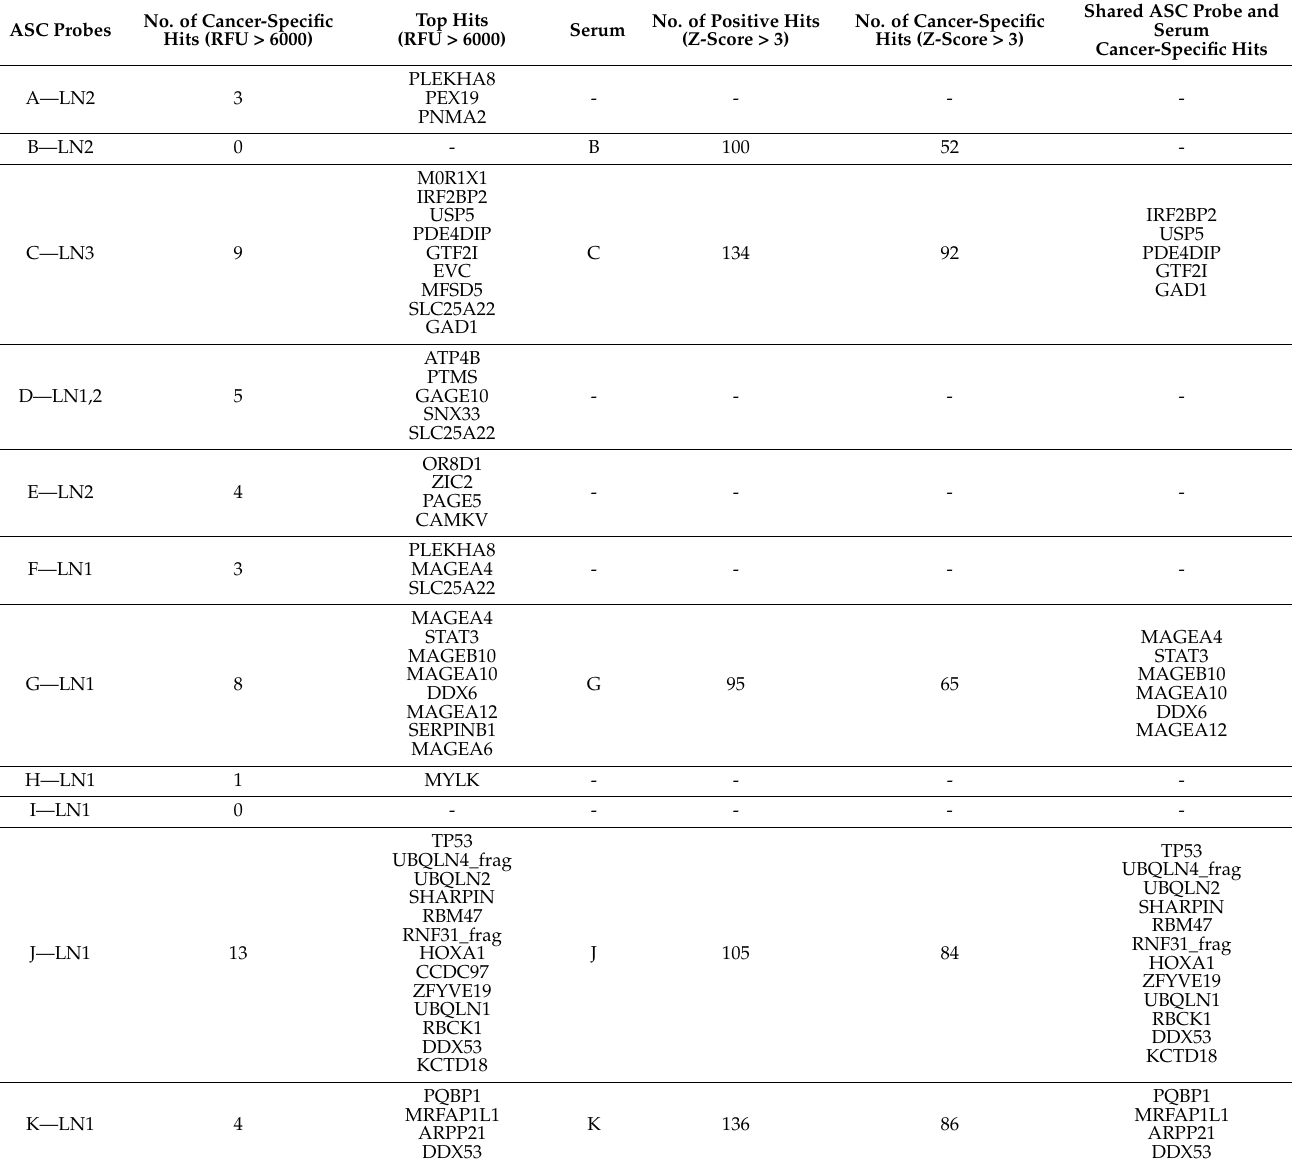
Table 2. Antigen reactivities identified with ovarian cancer cohort 1 using CDI HuProt TM arrays. Ovarian cancer ASC probes ( n = 11, A–K) and selected matched sera ( n = 5) were screened using CDI HuProt TM arrays. ASC